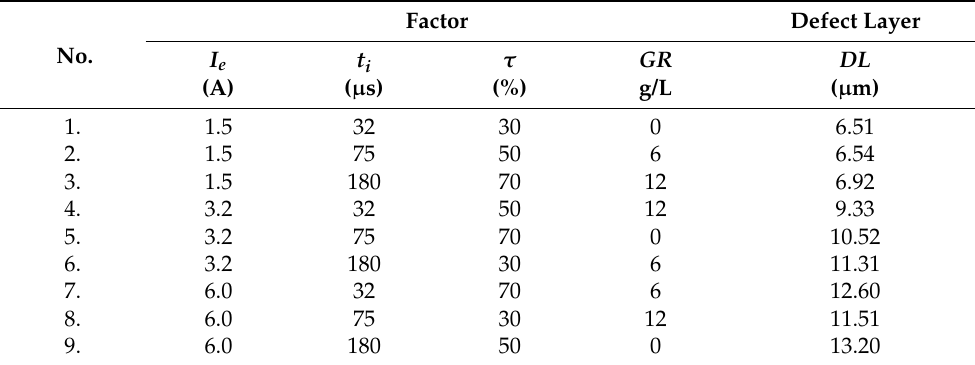
Table 3. Taguchi orthogonal array L 9 (3 4 ) at PMEDM TiAl 6 V 4.